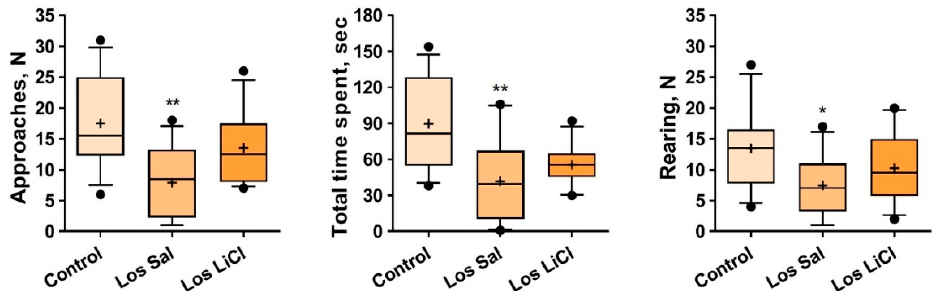
Figure 2. Effects of chronic LiCl treatment on the behavior of defeated mice in the partition test. Note: Los Sal - Sal-treated losers; and Los LiCl - LiCl-treated losers. Data are presented as means ( plus sign ), medians (solid lines), and 25%/75% quartiles in the box-whisker plot, with whiskers indicating the 10th and 90th percentiles. * p < 0.05 and ** p < 0.01 vs. controls; n = 12 for each group.